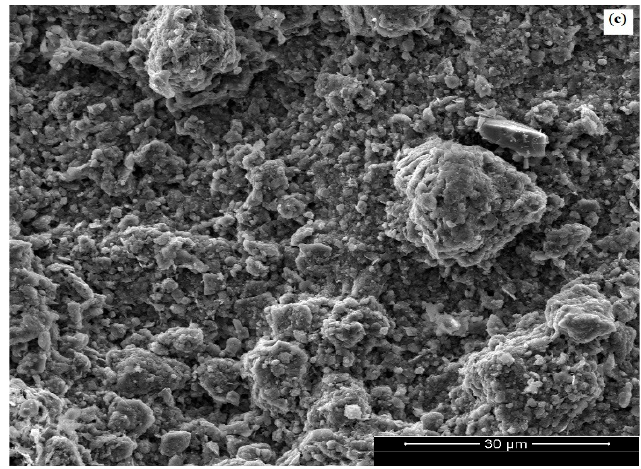
Figure 1. SEM micrographs of composite kaolin/sand membrane surface: sintered at 800 °C ( a ) 900 °C ( b ) and sintered at 1000 °C ( c ).